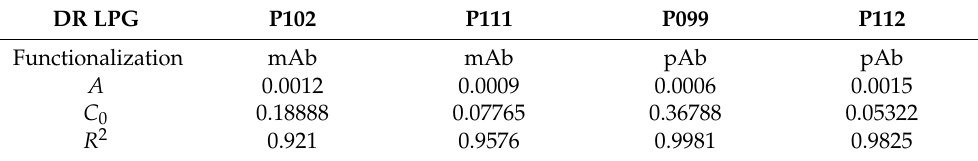
Table 3. Logarithmic fitting parameters for the response to protein